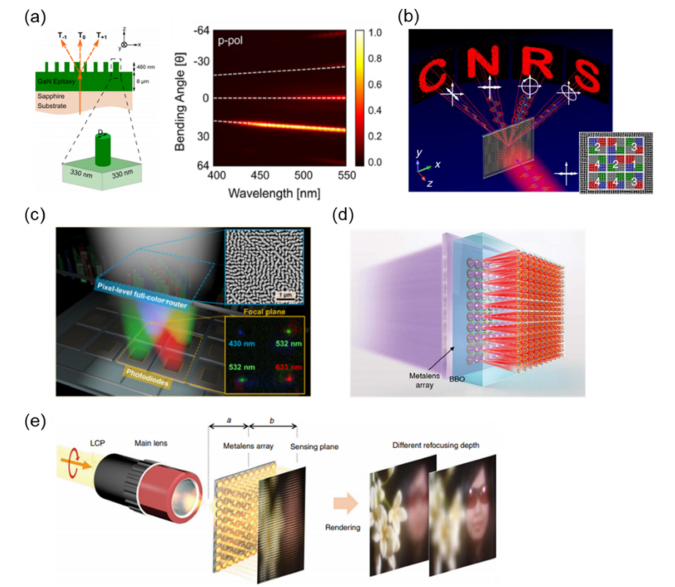
Figure 5. ( a ) Schematic of a metasurface (left); measured energy distribution of the metasurface illuminated by the p-polarized light (right) [81]. ( b ) Multidirectional metahologram; SEM image is shown in the inset [54]. ( c ) Multicolor router with a dielectric metalens in a CMOS image sensor [73]. ( d ) Quantum light source based on a metalens array [74]. ( e ) Light-field imaging application with a metalens array